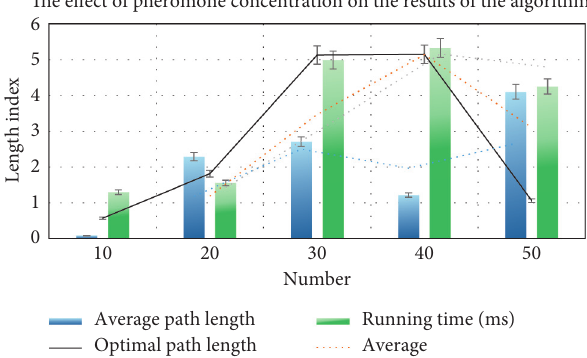
Figure 12: High-level education accounts for a large proportion. Table 12: Education structure of human capital in high-tech enterprises.